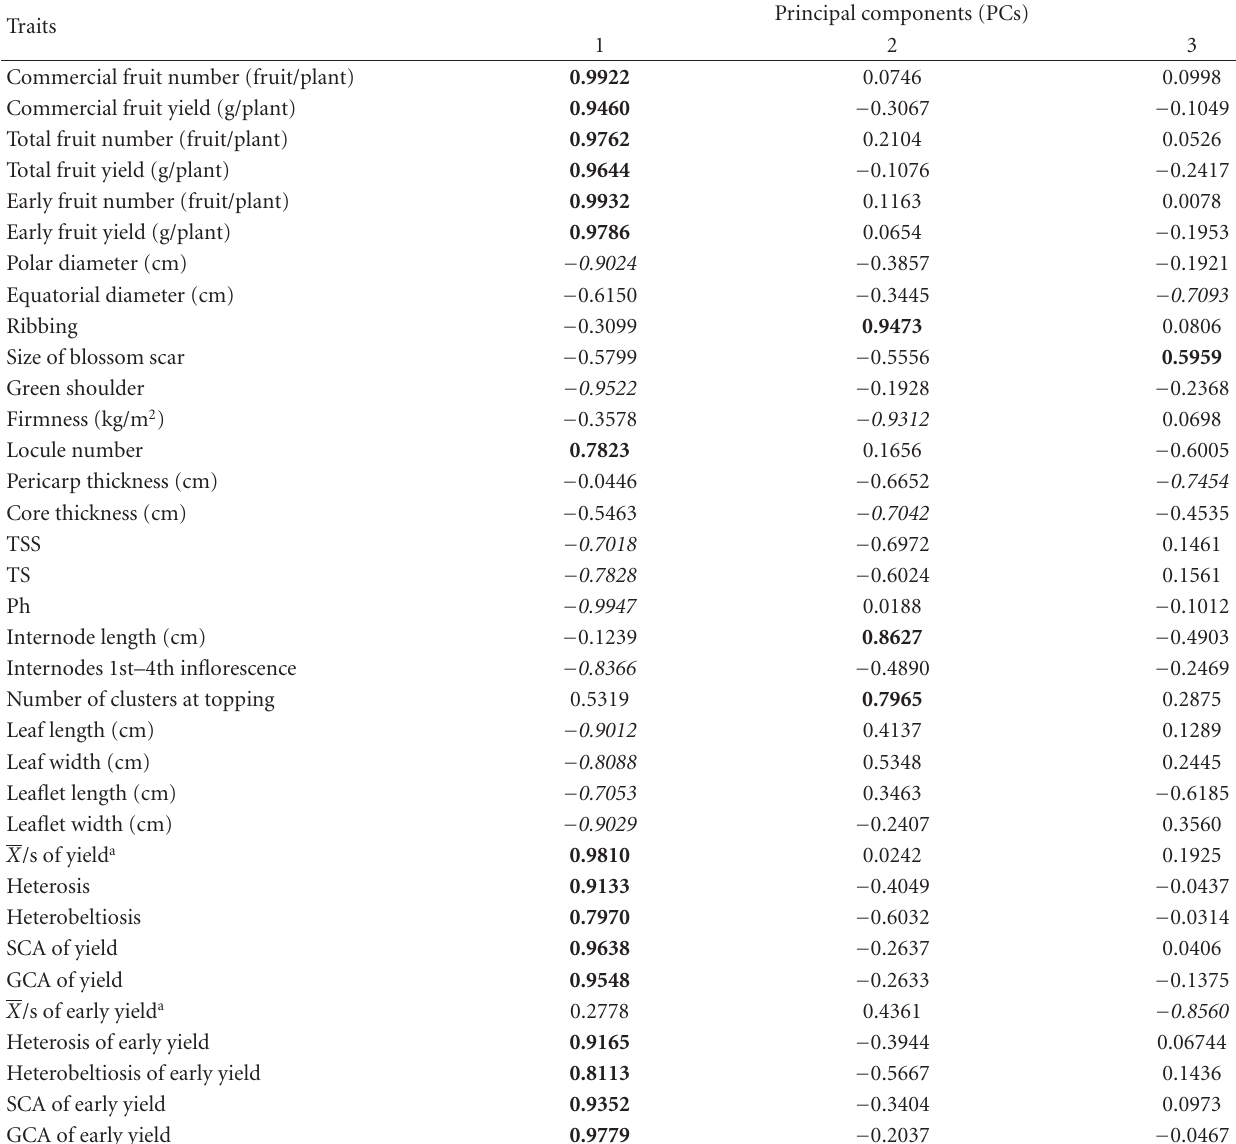
Table 6: Loadings of the traits onto three principal components for